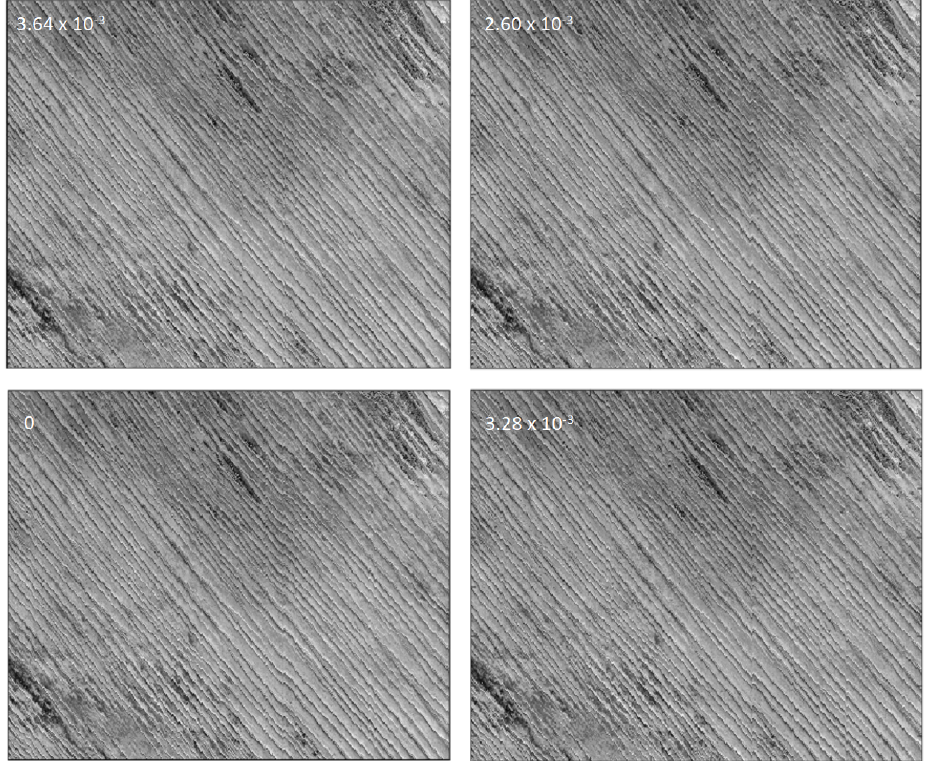
Figure 15. Contrast- stretched and zoomed-in band 5 Australian Desert image with: SS FPM gains applied ( Top Left ); CPF FPM gains applied ( Top Right ); In-scene FPM gains applied ( Bottom Left ); modeled FPM gains applied ( Bottom Right ). In the top-left corner of each scene is the overlap detector metric for that